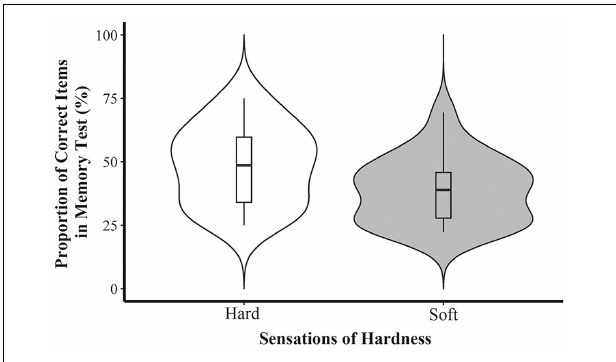
FIGURE 1 | Proportion of correct answers in recall task in Experiment 1. The white and gray areas display the data’s probability density; the thick horizontal lines inlayed into the box correspond to medians; the lower and upper “hinges” of the box represent the first and third quartiles; and whiskers extends from the corresponding hinge to the highest/lowest value that is within 1.5 × interquartile range of the hinge (subsequent figures also follow this